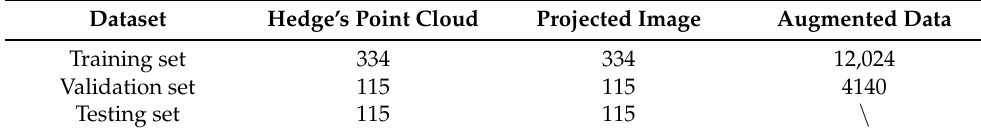
Figure 1. Data acquisition equipment and scene. In order to ensure that the LIDAR can acquire the height of the hedge from bottom to top, the installation height of the LIDAR in this study was about 0.8 m. In other working scenarios, the height of the LIDAR needs to be adjusted according to the height of the hedge. Table 1. The details of the